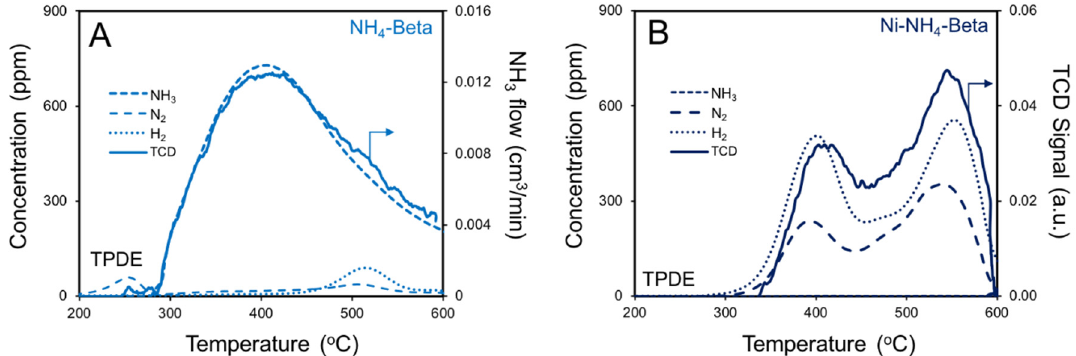
Figure 1. TPDE spectra. ( A ) NH 4 -Beta and ( B ) Ni-NH 4 -Beta after in situ pretreatment at 300